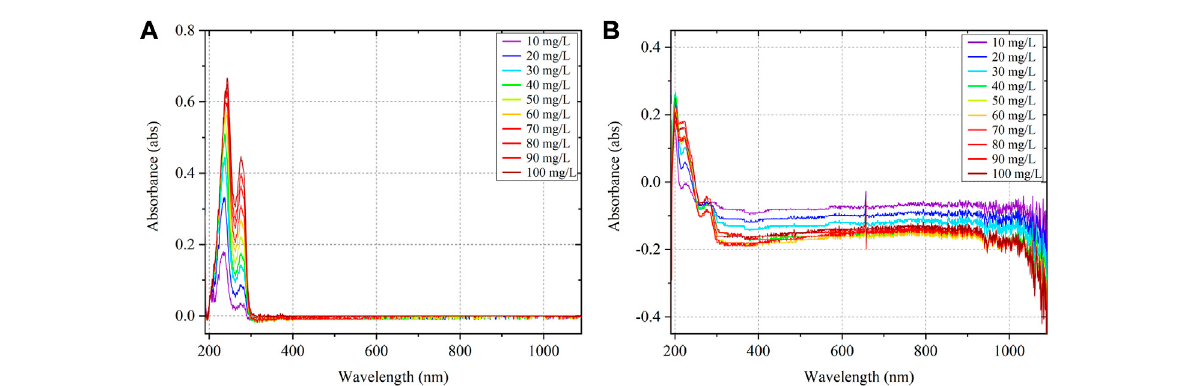
FIGURE 5 (A) Absorption spectra of 10concentrationsof COD samplesobtained bytransmissive method. (B) Absorptionspectra of10concentrations ofCOD samples obtained by re fl ective